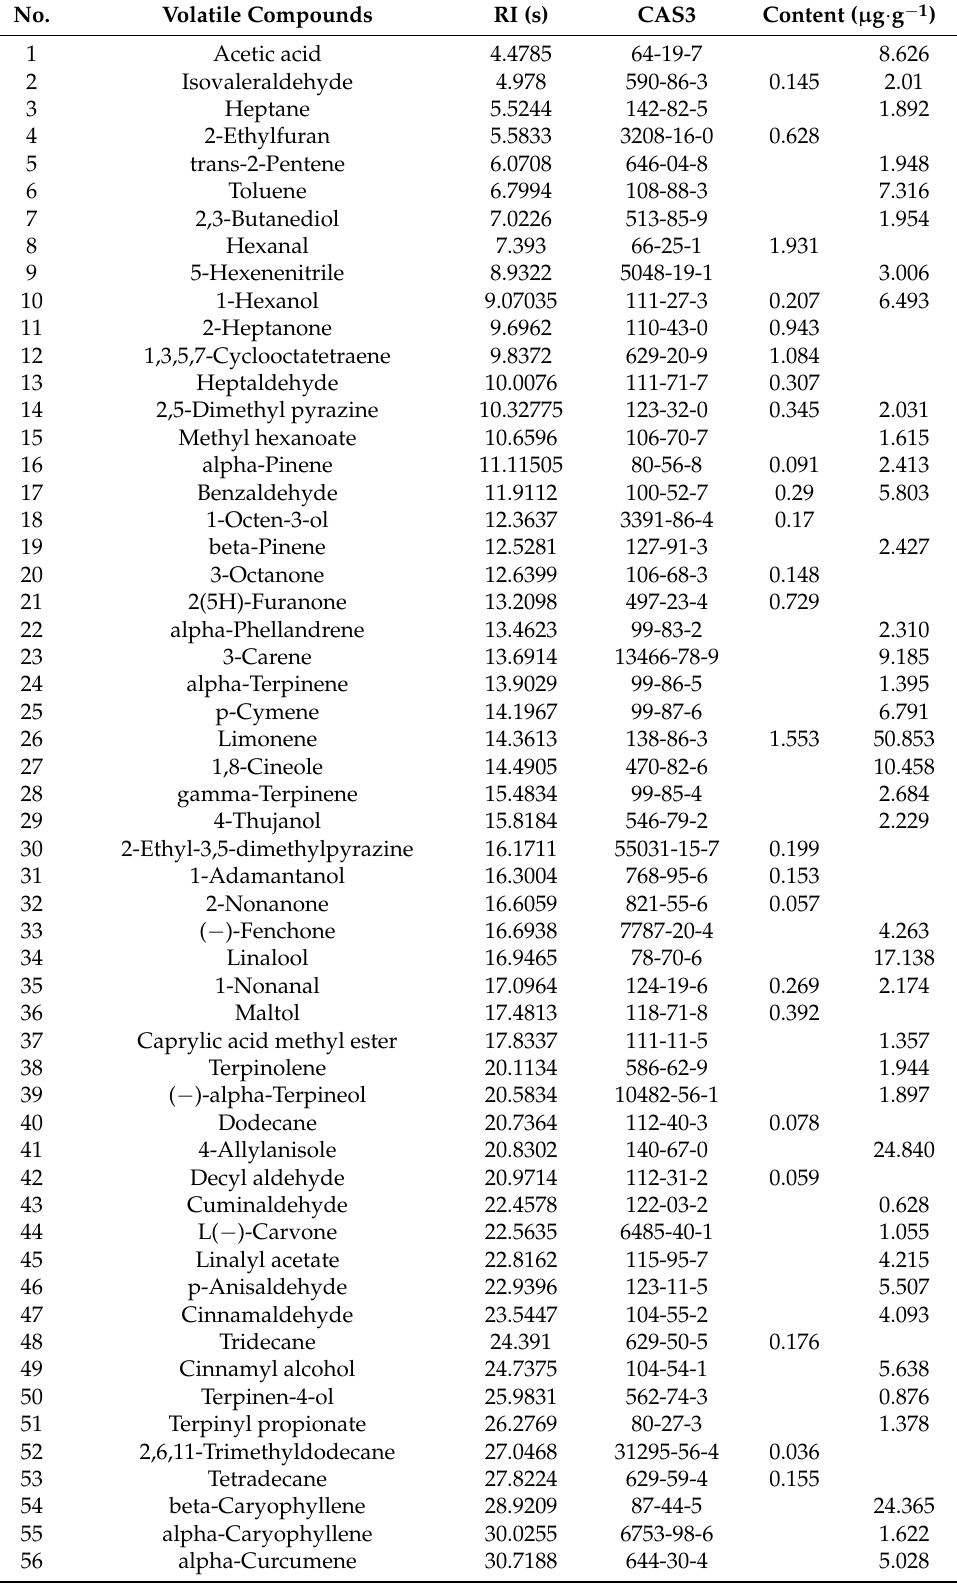
Table 3. Volatile compounds extracted from MMSA ( µ g g − 1 ) and DMMSA and analyzed using HS-SPME combined with